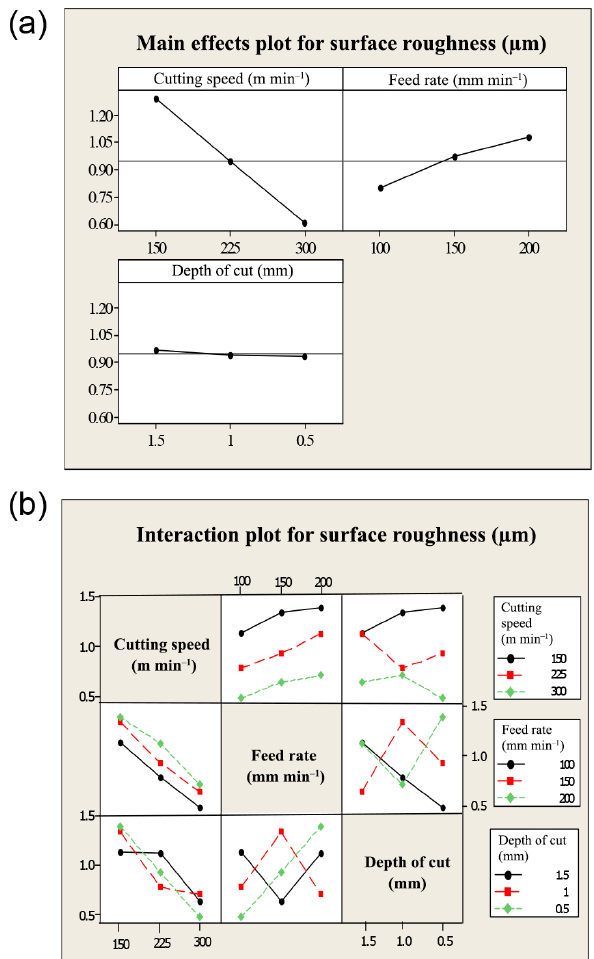
Figure 3. Individual parameters of machining affecting the surface quality: (a) main effects and (b)